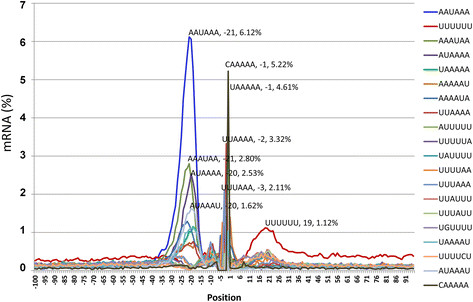
Most frequent 20 hexamer motifs in the poly(A) site region in 30499 unique poly(A) sites mapped to the human genome. Order in the peak point labeling: motif sequence, position, and frequency at the single specific position in the mapped poly(A) site regions (pre-mRNA). The AAAAAA motif was the highest at position 1, but the frequencies or AAAAAA and UUUUUU were inflated in counting, for example, a sequence of 8 A’s was counted as three copies of AAAAAA motifs when counting motifs at each position. It is why AAAAAA was not showing in the figure here. The UUUUUU motif listed here was to show the location of the frequency peak. The most abundant five motifs, in terms of the values of the highest peaks were AAUAAA, CAAAAA, UAAAAA, UUAAAA, and AAAUAA. The top five motifs, in terms of the number of accumulated copies along the 201-base region were AAAAAA (135.84%), AAUAAA (75.64%), UUUUUU (73.87%), AAAUAA (46.93%), AUAAAA (41.40%). Note that the most frequent motifs are mainly on three places: the −21 position region (upstream A-rich element; mainly AAUAAA), the poly(A) site, and the downstream U-rich region with peak location approximately at +19. No highly abundant hexanucleotide motifs were detected from other regions.